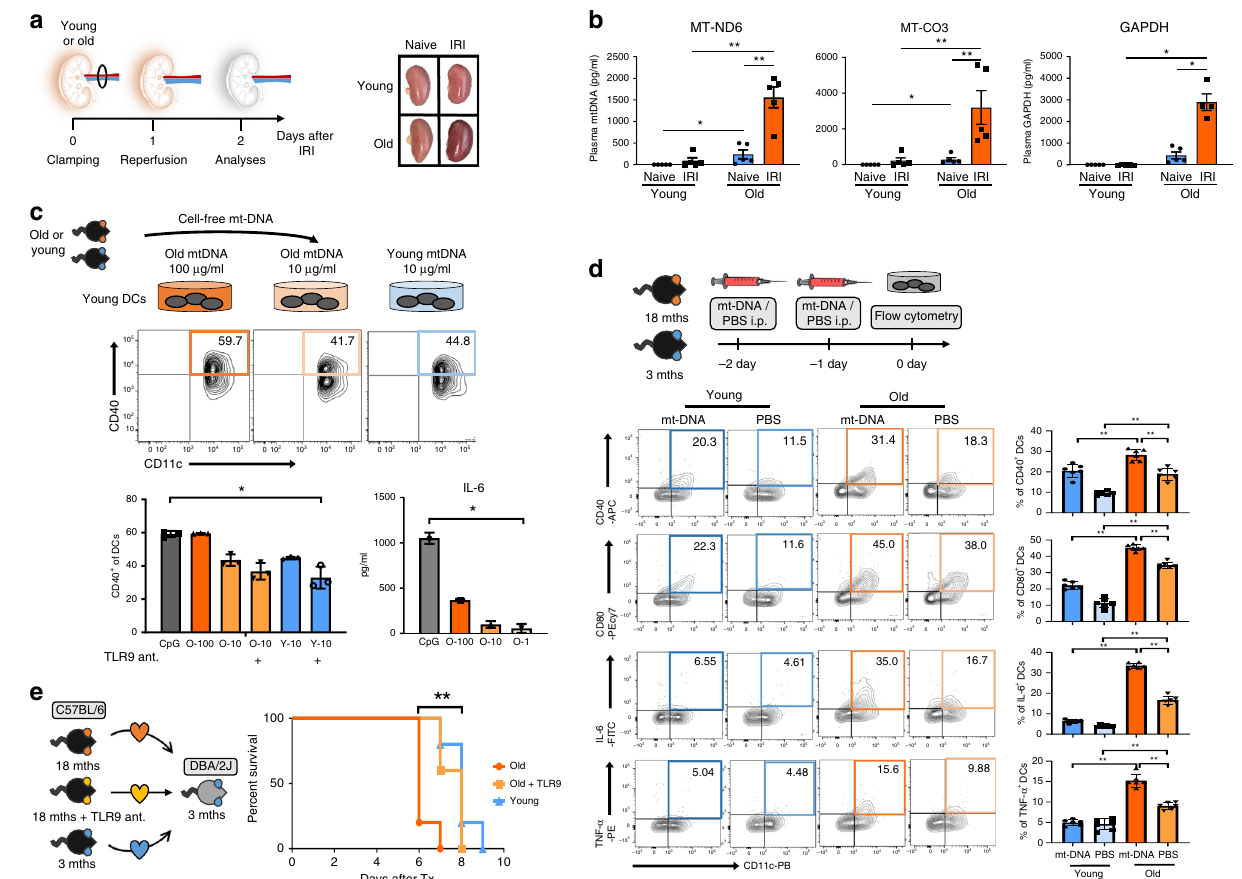
Fig. 3 Systemic cf-mt-DNA increases upon IRI in old mice and promotes DC maturation through TLR9. a Ischemia reperfusion injury was induced by clamping the renal pedicle of young and old C57Bl/6 (2 and 18 months) mice for 22min, respectively. IRI and naive animals were euthanized after 48h and kidneys were procured. The image shows the macroscopic appearance of kidneys directly after IRI. b Cell-free mitochondrial DNA (cf-mt-DNA) was quanti fi ed in plasma by real-time PCR according to standard curve results (young IRI vs. old IRI for mt-CO3: p = 0.0079); Column plots display Mean± SEM; ( n = 5 biologically independent animals). c Different concentrations of cf-mt-DNA isolated from young and old mice were added to DC cultured from young mice, costimulatory molecule expression was analyzed by fl ow cytometry with or in absence of a TLR9 antagonist (CpG vs. young + TLR9 ant: p = 0.0376), and Il-6 production was measured by ELISA (CpG vs. O1: p = 0.0134); statistical signi fi cance was determined using Kruskal – Wallis test with Dunn´s post hoc test; ( n = 3 biologically independent samples). d Young or old C57BL/6 mice were injected i.v. with either 30 mg mt-DNA or PBS for 2 consecutive days. Subsequently, costimulatory molecule and cytokine expression of splenic DCs was analyzed by fl ow cytometry (young + mt-DNA vs. old + mt-DNA: ( p = 0.0022); ( n = 6 biologically independent animals). e Immediately after receiving a fully mismatched cardiac allograft from 18 months old C57Bl/6 donor mouse, 3 months old DBA2/J recipient mice were treated every 24h with an i.p. TLR9 antagonist for the follow-up period ( p = 0.0009), ( n = 5 biologically independent animals); results are representative of at least three independent experiments. Column plots display mean with standard deviation. Statistical signi fi cance was determined using two-tailed Mann – Whitney test. Survival was compared by log-rank Mantel – Cox test. Asterisks indicate p values * p ≤ 0.05, ** p ≤ 0.01, and *** p ≤ 0.001, only signi fi cant values are shown. Source data are provided as a Source Data fi